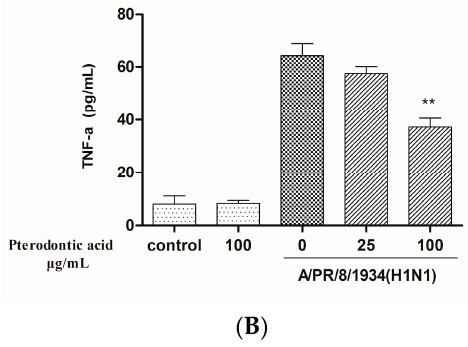
Figure 6. Pterodontic acid inhibited pro-inflammatory expression in influenza virus A/PR/8/34 (H1N1)-infected A549 cells. ( A ) A549 cells were infected with influenza virus (MOI = 0.2) in the presence or absence of different concentration of pterodontic acid for 24 h. Then, Total RNA was extracted and measured by qRT-PCR for the expression levels of IL-6, IP-10, MIP-1 β , and MCP-1. The expression of each target gene was normalized to GAPDH; ( B ) The protein levels of cytokines and chemokines in the culture supernatant were assayed by luminex 24 h post A/PR/8/34 infection alone or in combination with pterodontic acid at 25 and 100 μ g/mL. Each experiment was repeated in triplicate. * p < 0.05, ** p < 0.01, *** p < 0.001, relative to virus control.